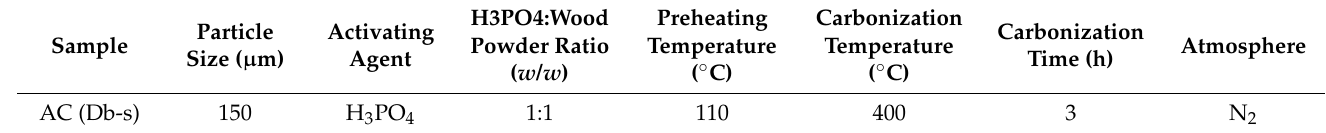
Table 2. Description and preparation conditions of the sample.